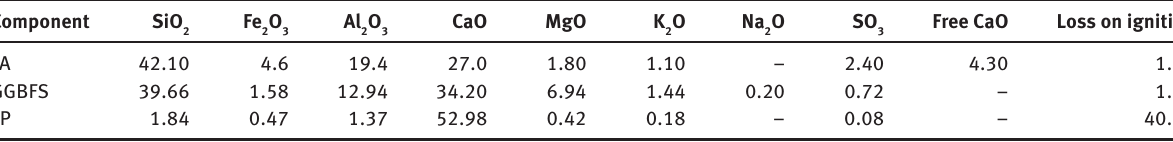
Table 2 Chemical composition of FA, GGBFS, and LP (mass%).